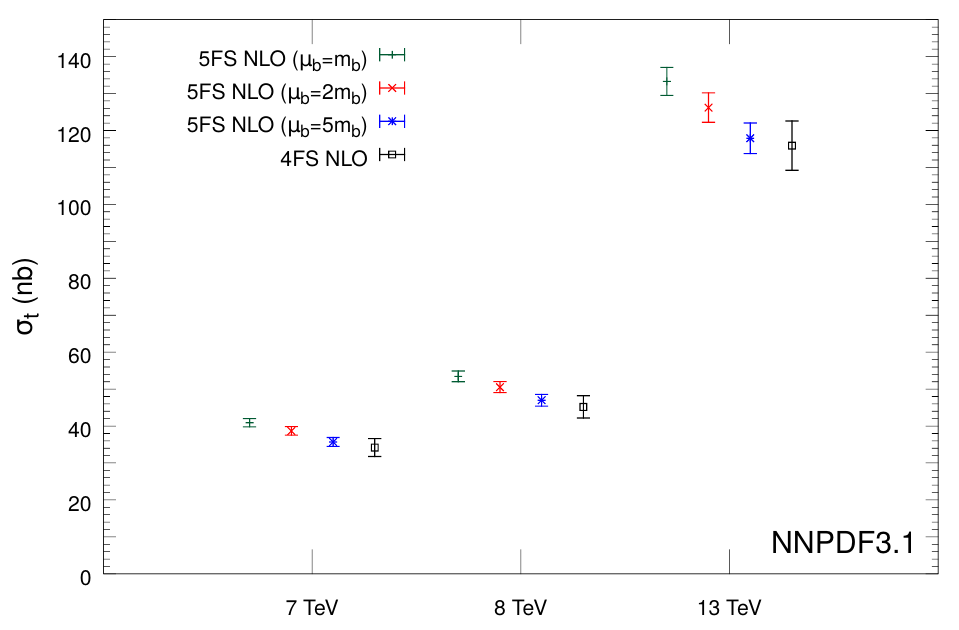
Figure 8 . Comparison between 4FS and 5FS NLO predictions for (cid:22) f = (cid:22) r = m t and varying (cid:22) b . We display predictions at NLO for (cid:22) b = m b ; 2 m b and 5 m b , and compare them to the 4FS NLO